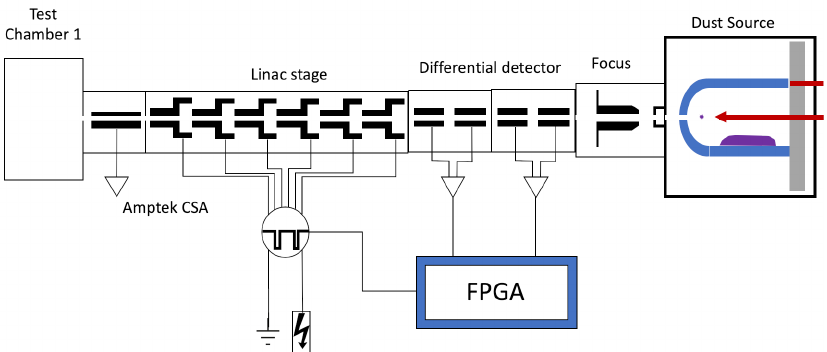
Table 1 and will be described in detail in the following